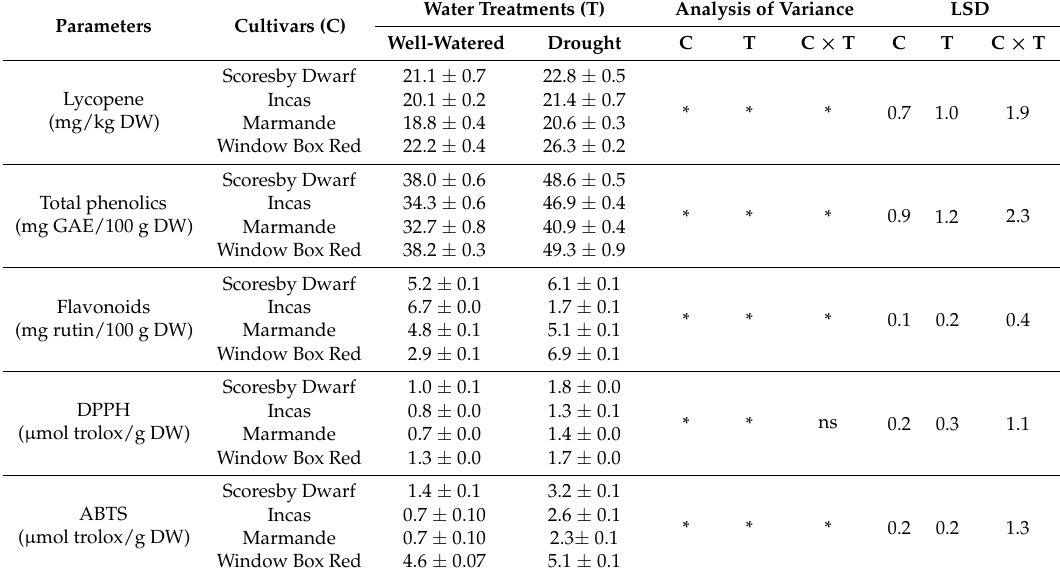
Table 2. Antioxidant compounds and antioxidant activities (DPPH activity and ABTS assay) evaluated on four tomato cultivars grown under well-watered and drought